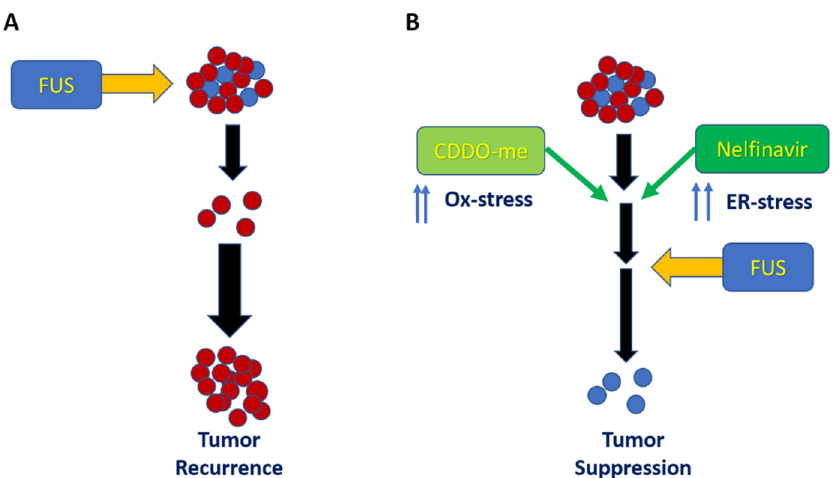
Figure 7. Putative effect of FUS alone ( A ) or pre-sensitization followed by FUS exposure ( B ) on tumor suppression. A combined mechanochemical disruption (MCD) approach may suppress the recurrence of aggressive cancer cells. Pre-sensitization of PCa cells with the oxidative stress (Ox-stress) inducer, CDDO-me, and the endoplasmic reticulum stress (ER-stress) inducer, nelfinavir, may increase the anticancer potential of low-dose FUS and decrease tumor recurrence.